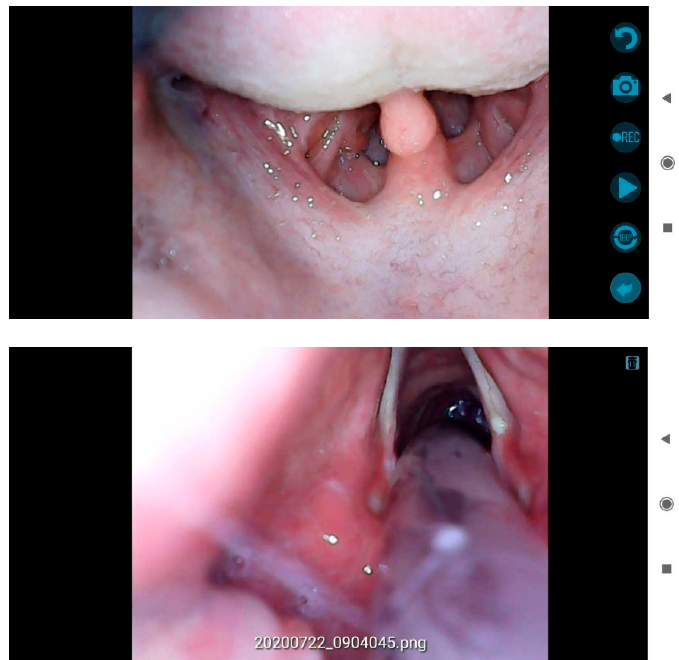
Figure 4. Example of app screenshots obtained with the proposed VDL Hybrid 1.0 during an endotracheal intubation in a real patient. Top: a screenshot while recording video. Bottom: a saved image using the app. The app activities are executed by selecting the blue buttons shown on the right edge of the screen.